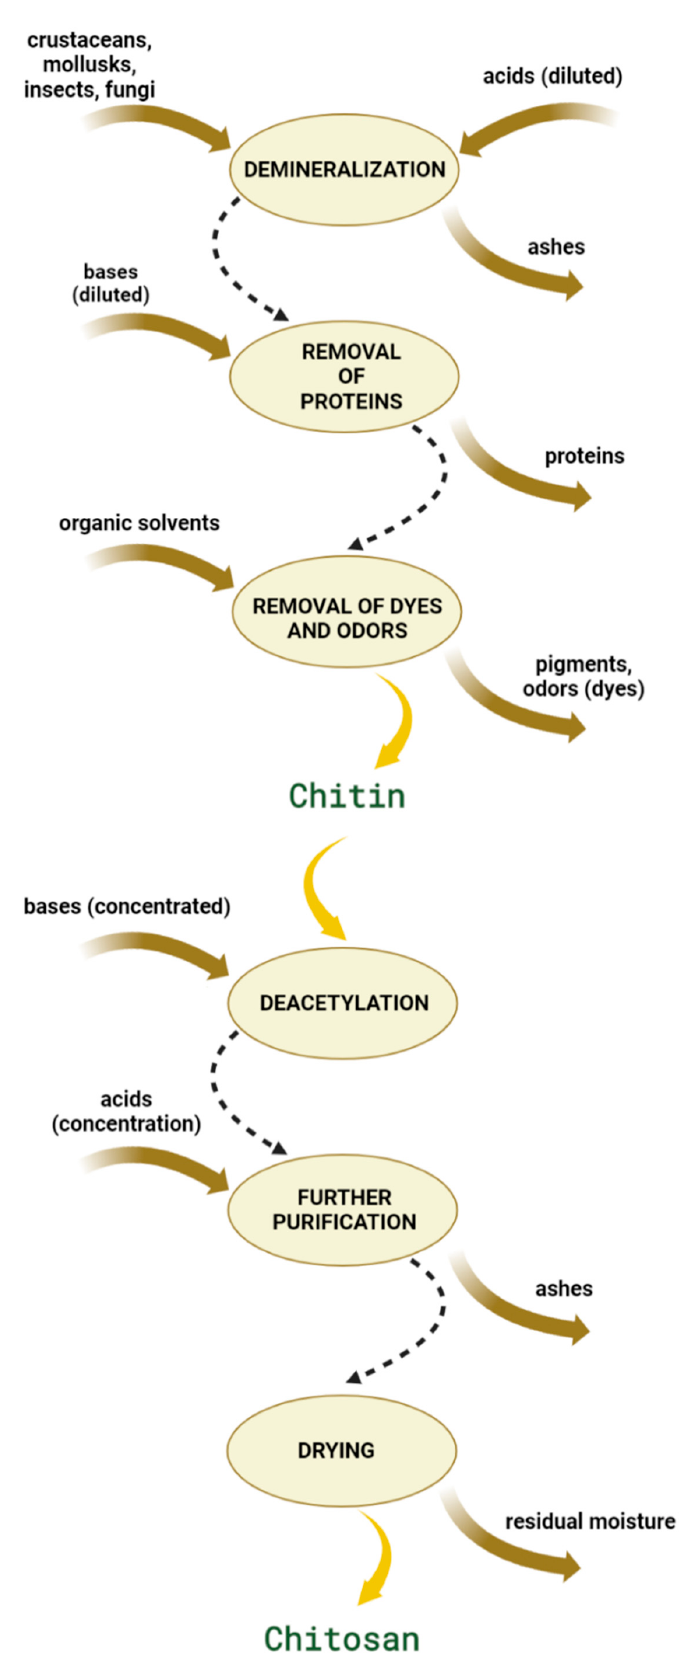
Figure 2. Scheme showing the production of chitosan from chitin using the conventional method.